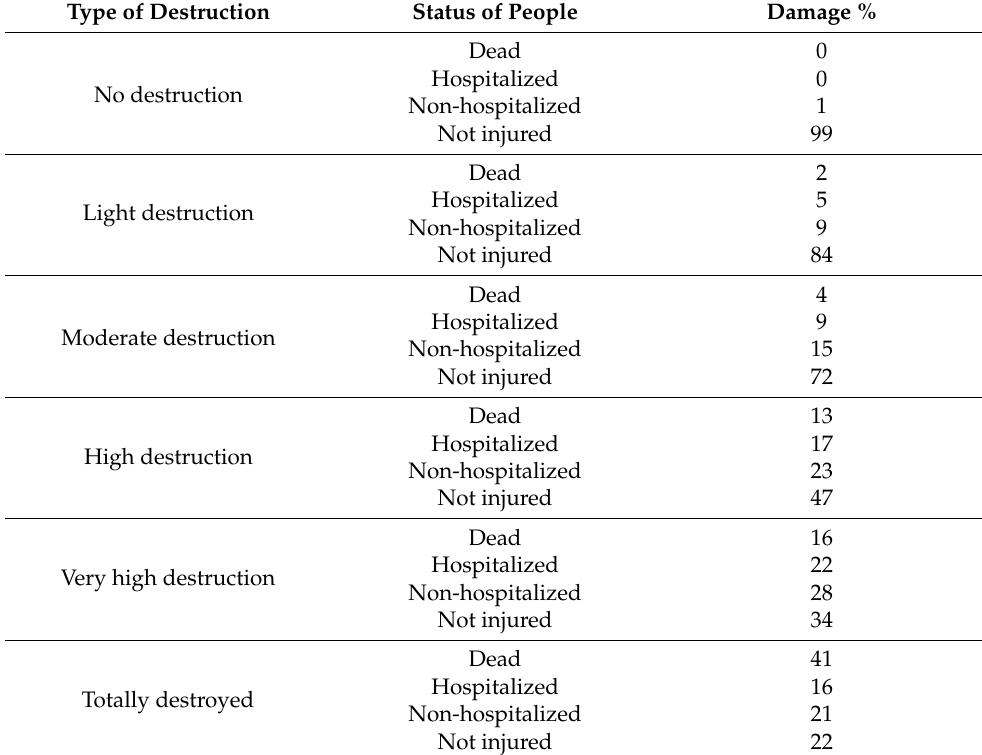
Figure 19. Population density of Tabriz city in 2019. Table 6. Classification of the expected population damage based on questionnaire surveys and reports of previous earthquakes in Iran [94]. Karmania Hazard Model User Manual. Kerman, Iran: Kerman Disaster